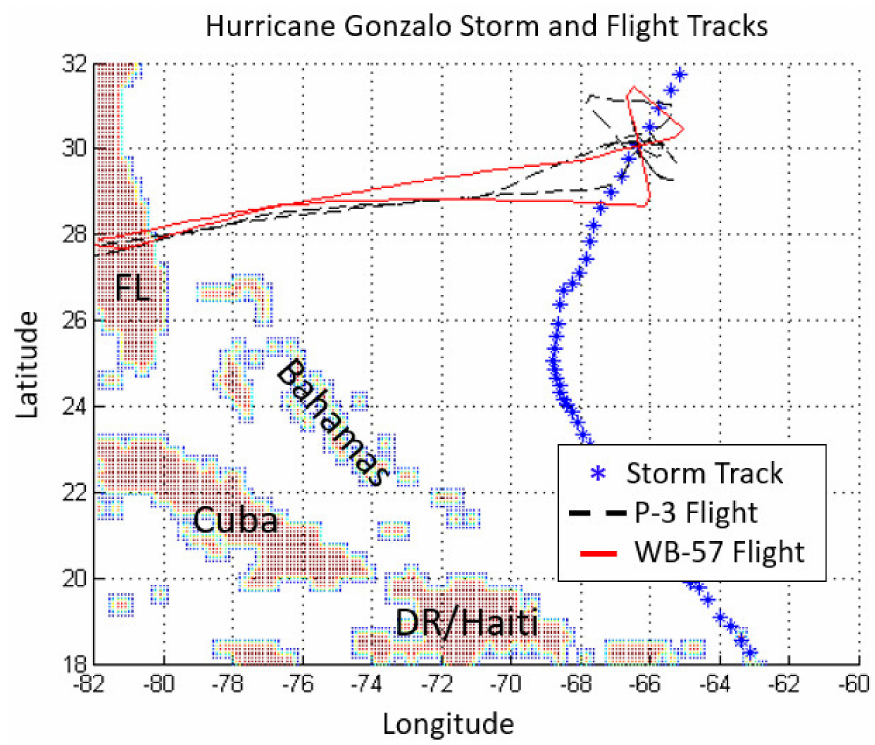
Figure 1. Hurricane Gonzalo multiday track (blue) and associated P-3 flight track (black) and WB-57 flight track (red) for 17 October.